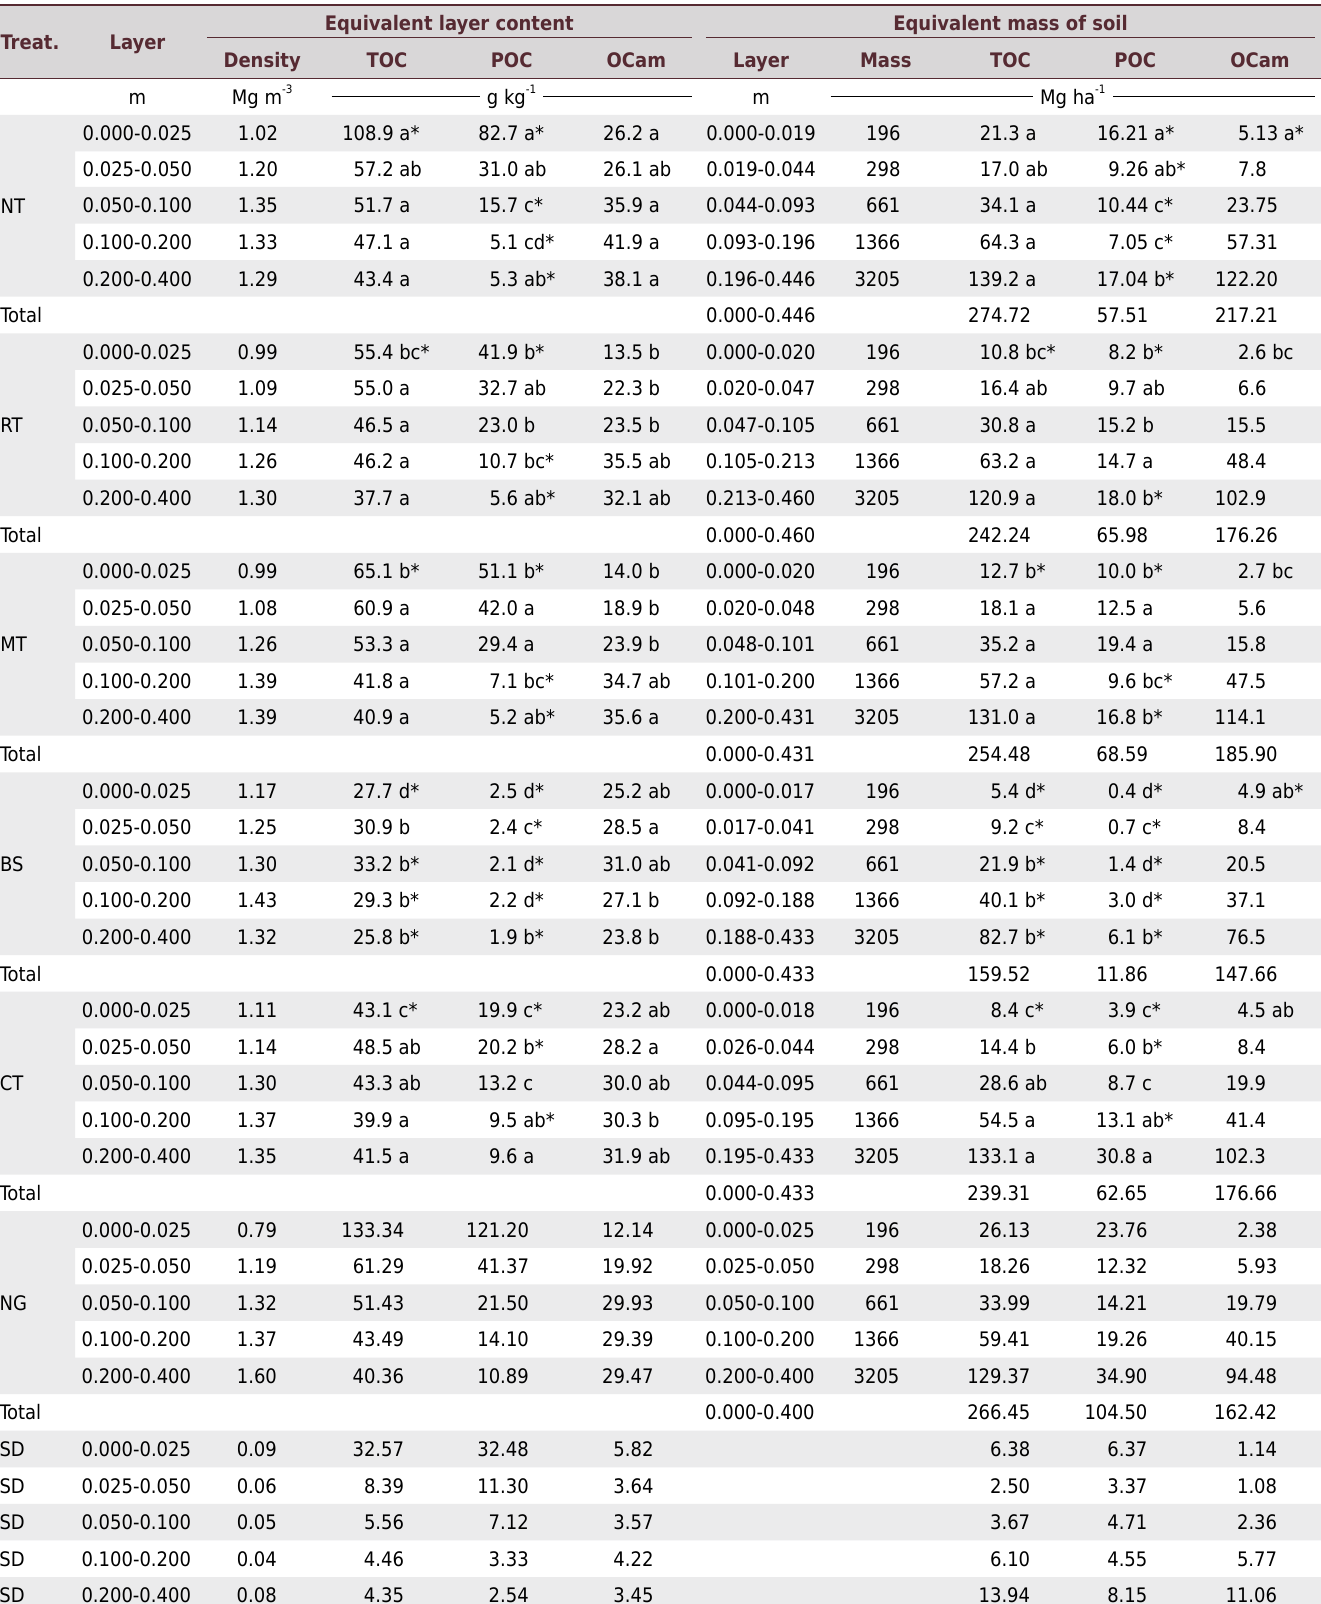
Table 1. Contents and stocks of total organic carbon (TOC), particulate organic carbon (POC), and organic carbon associated with minerals (OCam) in an Inseptisol after 27 years under various soil tillage methods: no-tillage (NT), rotating tillage (RT), minimum tillage (MT), bare soil (BS), conventional tillage (CT), and natural grassland (NG) as a reference